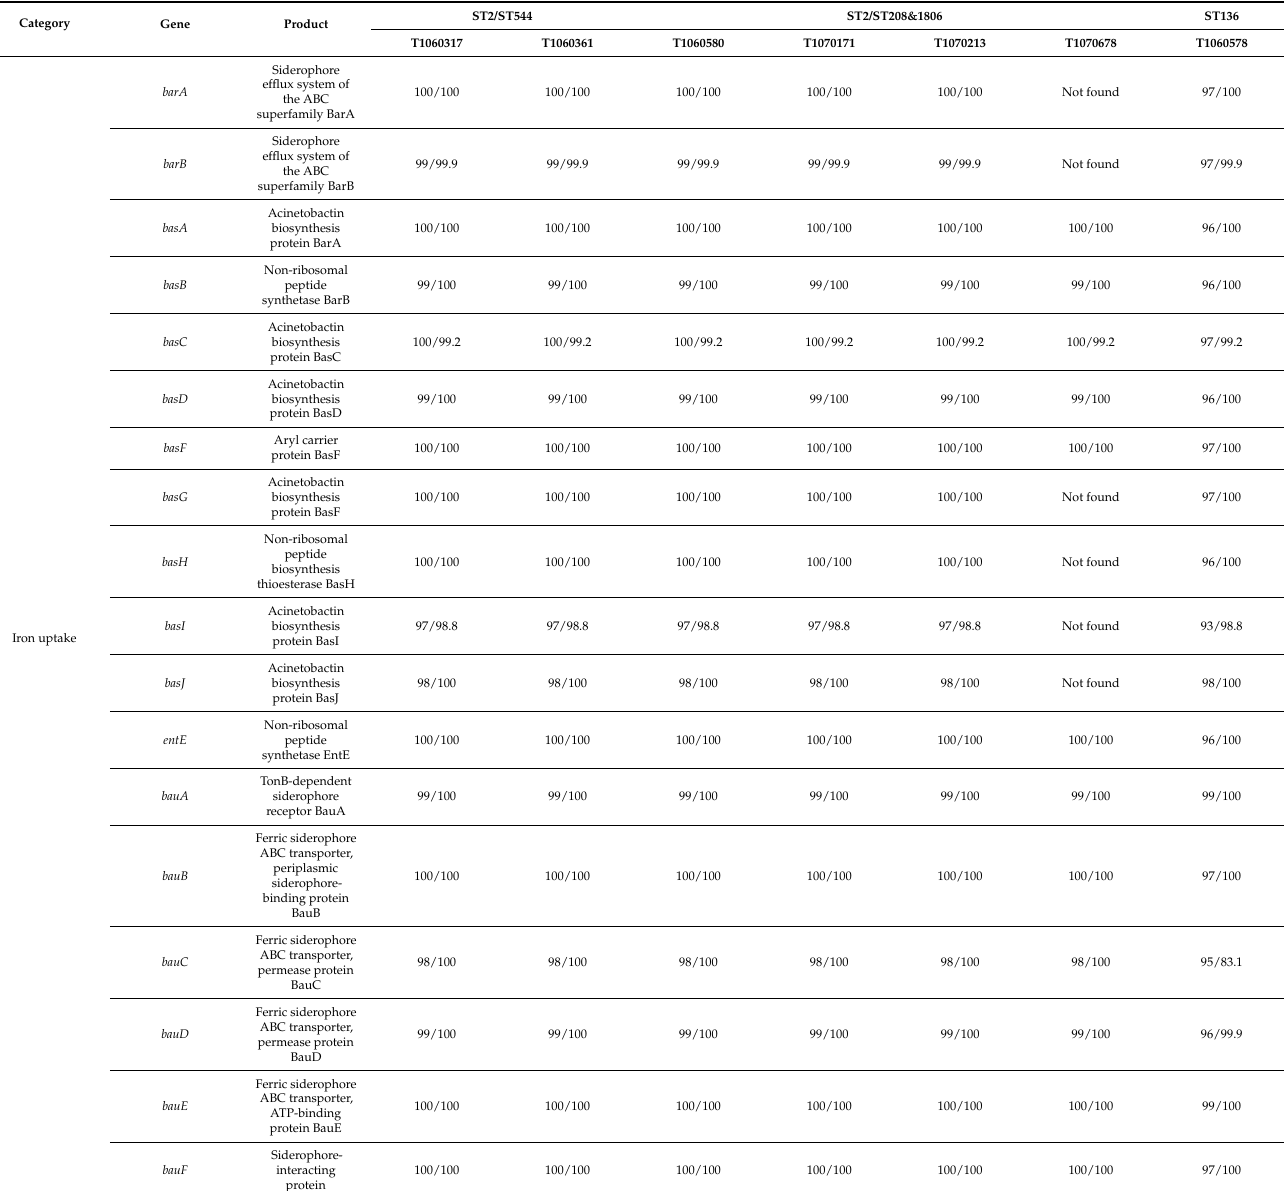
1 Values represent identities and coverages of nucleotide sequence comparison between our isolates and the reference A. baumannii ACICU. The gray color indicates 100% identity to the reference in both identity and coverage. 2 PNAG: Poly-beta-1,6-N-acetyl-D-glucosamine. A 33% prevalence of colistin heteroresistance in Acinetobacter spp. based on a meta- analysis has been reported [58]. In the seven CCR-AB isolates, six displayed stable resis- tance to colistin with a higher than 40% survival rate at the highest colistin concentration tested (64 mg/L). The other isolate, T1070678, displayed heteroresistance with 3.8 × 10 − 2 survival at 16 mg/L of colistin (Figure 5). T1070678 contains a P233S substitution in PmrB, which is known to be associated with stable resistance [59]. No reported mutations in pmrA or pmrB are known to be involved in heteroresistance. It is possible that colistin heteroresistance in T1070678 may be attributed to elevated efflux pumps, as has been previously reported